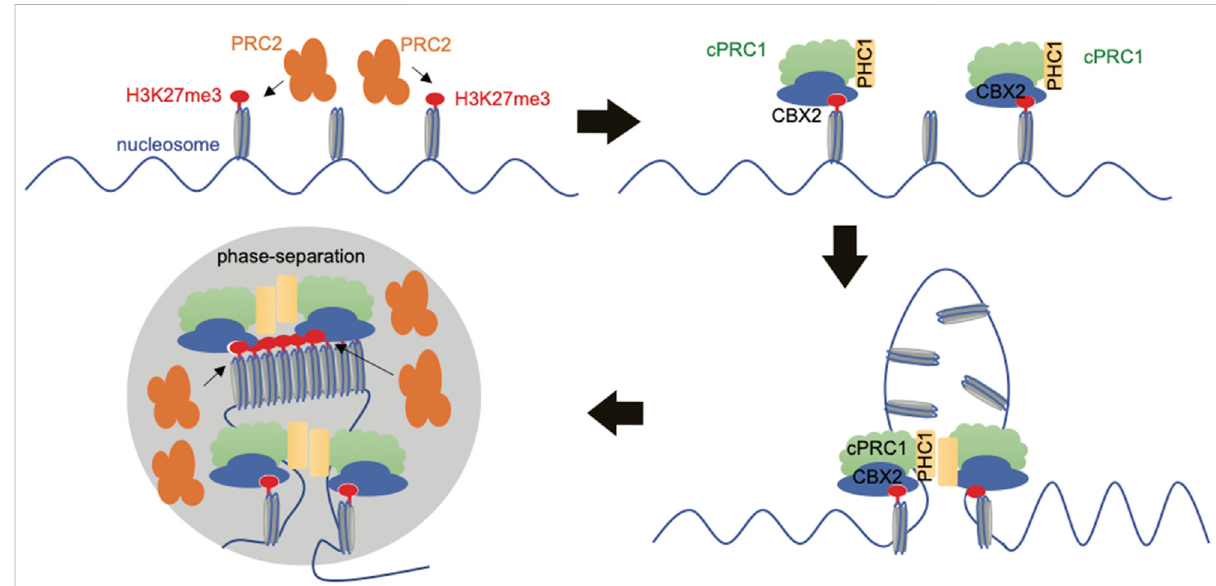
FIGURE 3 Schematicto show formation of Polycomb Associated Domains (PADs).PRC2 deposits H3K27me3, preferentially atregions with unmethylated CpG-richsequence.H3K27me3isthen “ read ” bytheCBXsubunitofcPRC1.ThecPRC1variantcomplexthendriveschromatincompactionbyliquid- liquid phase separation (LLPS), which is at least achieved through the subunit of CBX2 (with its chromodomain reading H3K27me3 while its IDRs mediating LLPS) and/or PHC1 (with the SAM domain mediating LLPS). PRC2 deposits more H3K27me3 marks to maintain PADs and repression of the embedded